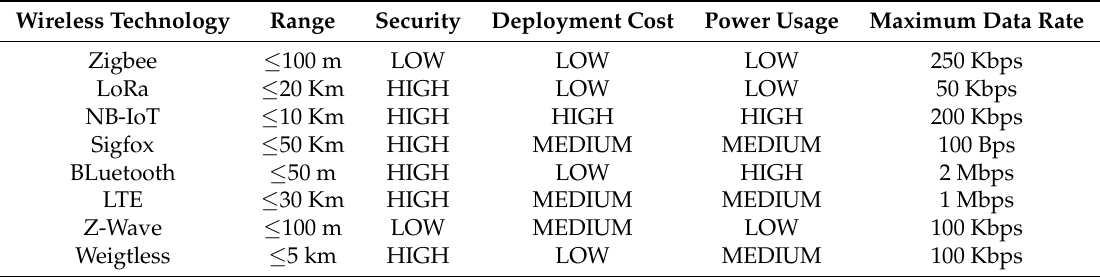
Table A2. Wireless technologies comparison table